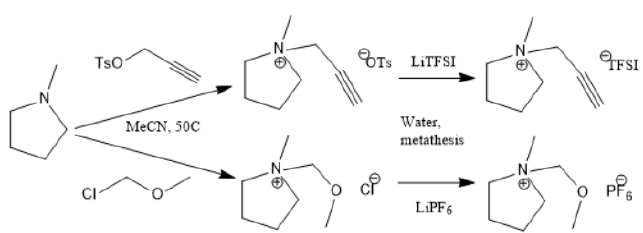
Figure 3. Synthetic strategy to pyrrolidinium ILs.